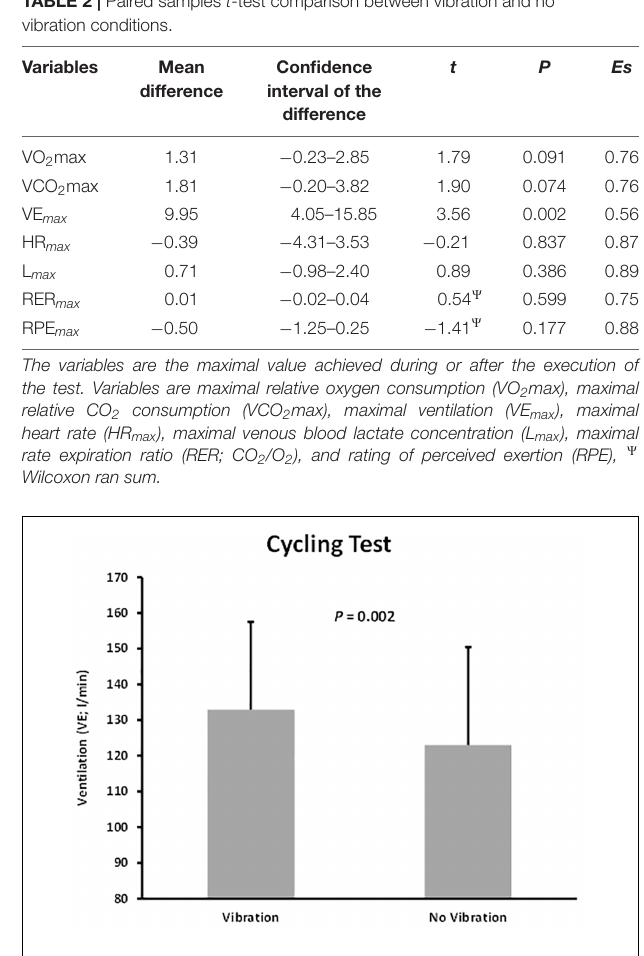
FIGURE 3 | Differences of ventilation between the vibration and no vibration conditions during graded maximal cycling test.